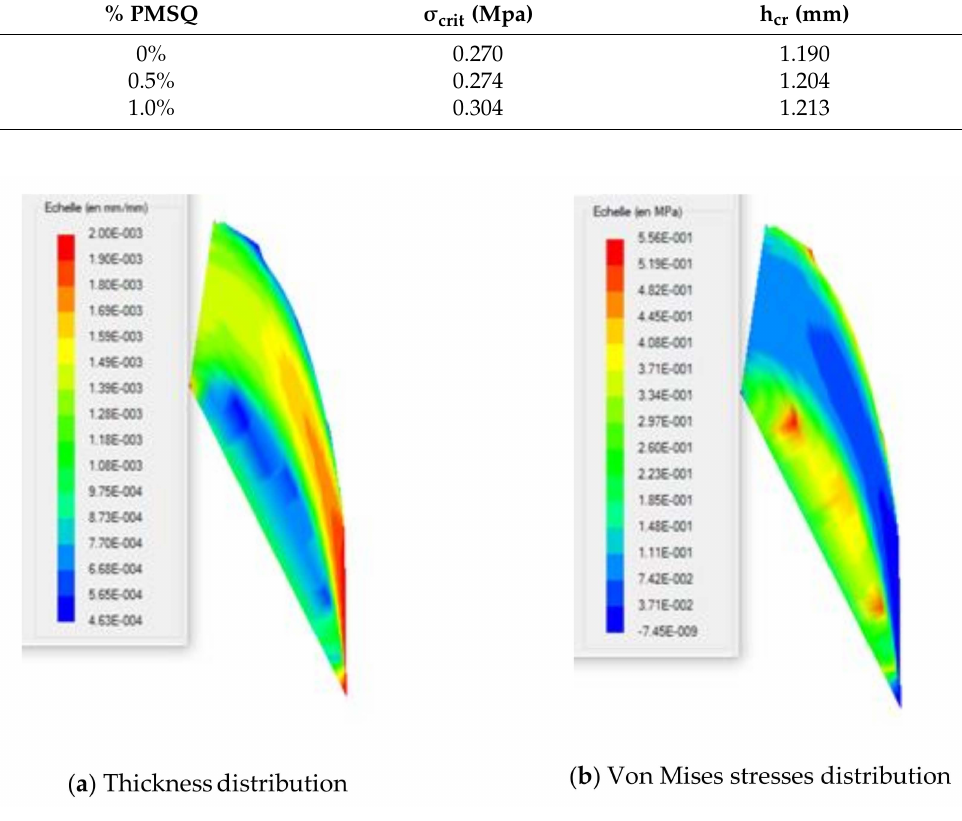
Figure 12. Distributions of the final thickness and the von Mises stresses in the thermoformed blade. Figure 13 shows the work required over time for thermoforming HDPE, HDPE-PMSQ1 and HDPE-PMSQ2. This work takes the values of 15.16, 15.27 and 15.29 joules for virgin HPDE, HDPE-PMSQ1 and HPDE-PMSQ2, respectively. From a cost-benefit standpoint,